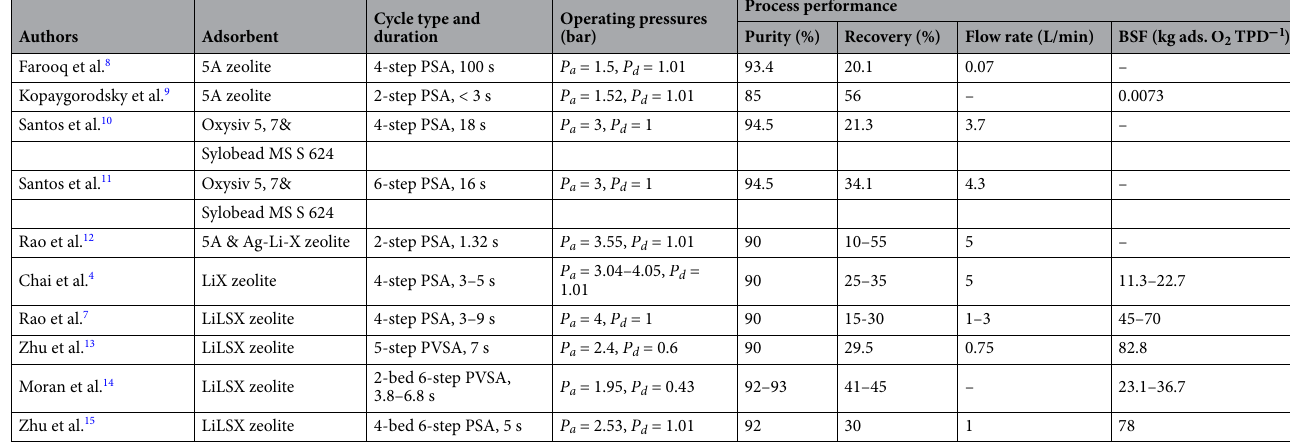
Table 1. Literature studies on adsorption-based air separation for medical grade oxygen